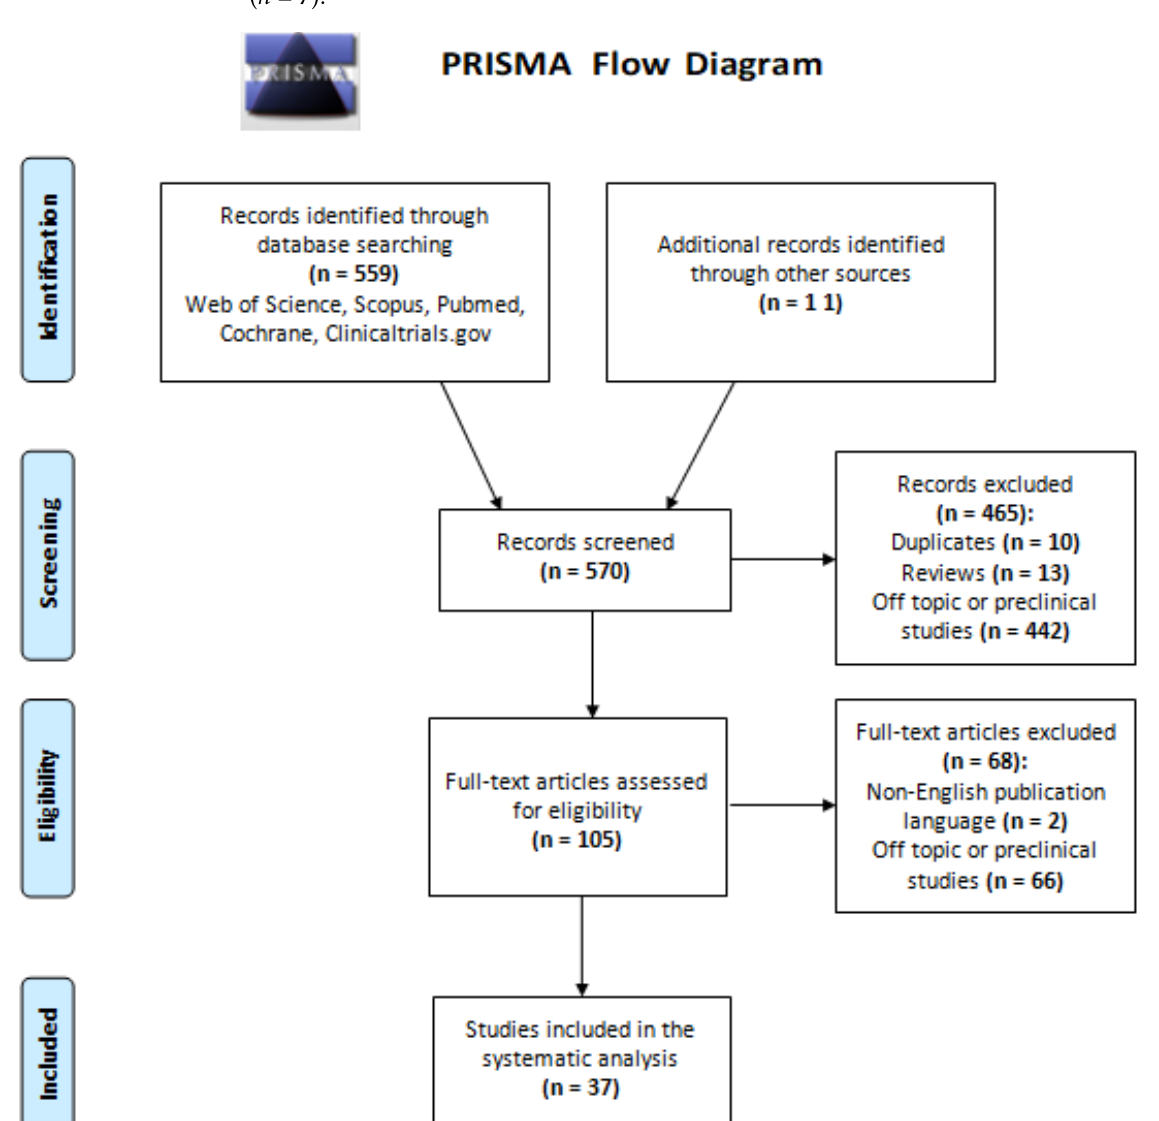
Figure 1. Flowchart of the systematic scoping review in accordance with PRISMA guidelines [13].